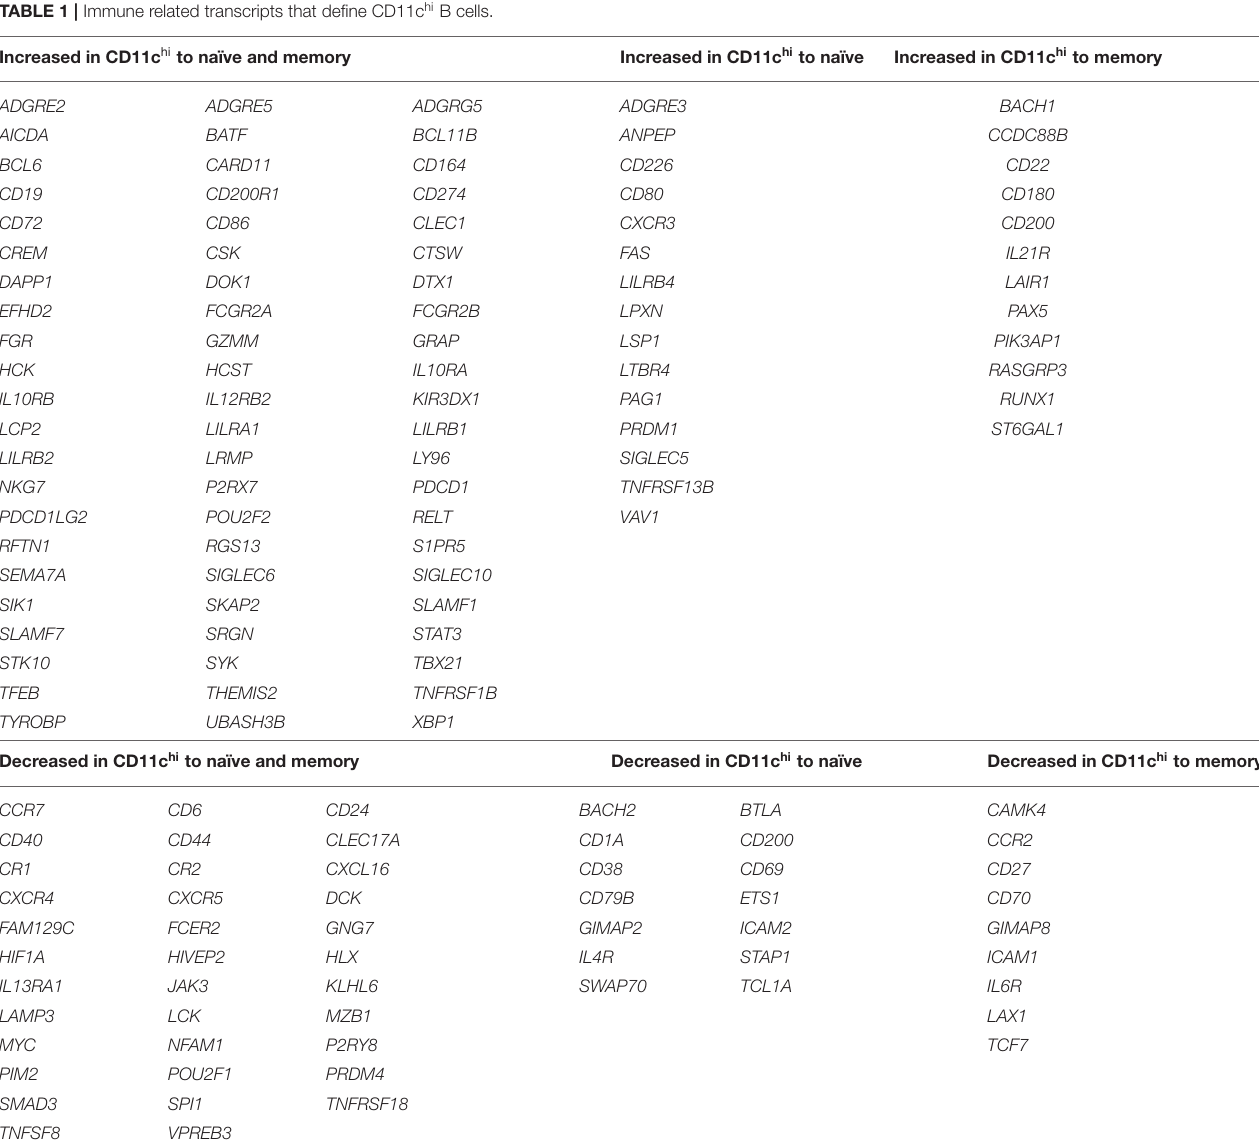
TABLE 1 | Immune related transcripts that define CD11c hi B cells. Increased in CD11c hi to naïve and